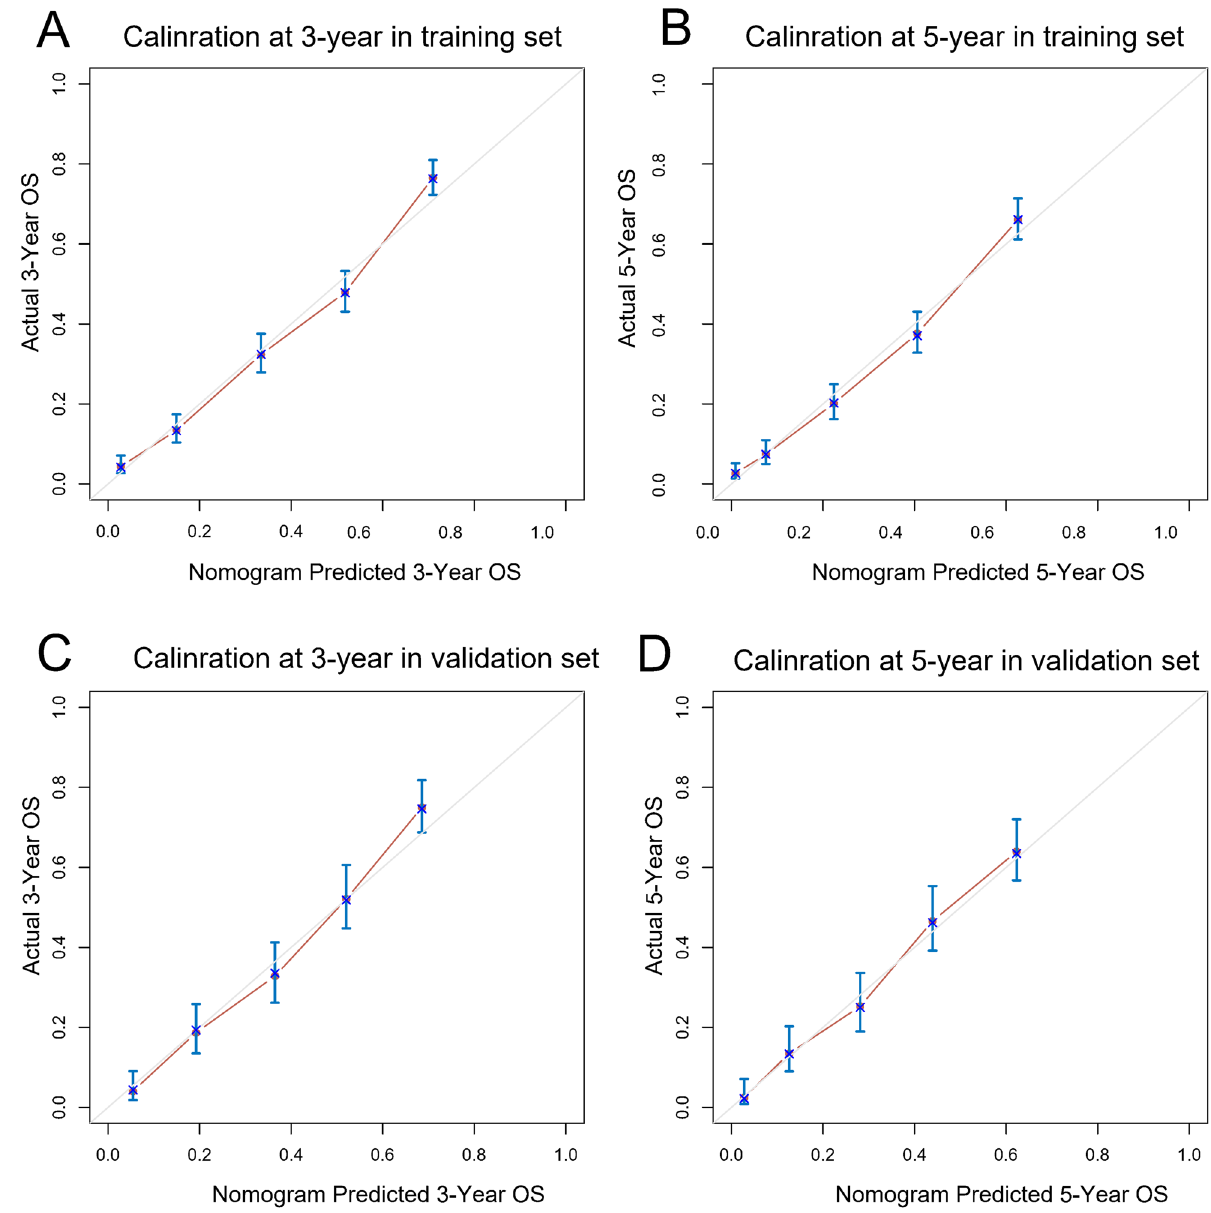
Figure 3. Calibration plots of nomogram to predict 3- and 5-year overall survival (OS) in training ( A , B ) and validation cohorts ( C , D ). The X-axis indicated nomogram-predictive survival; the Y-axis suggested actual CSS. A plot with 45-degree line was suggestive of a perfect calibration where predictive possibilities were identical to actual ones. Vertical bars indicated 95%